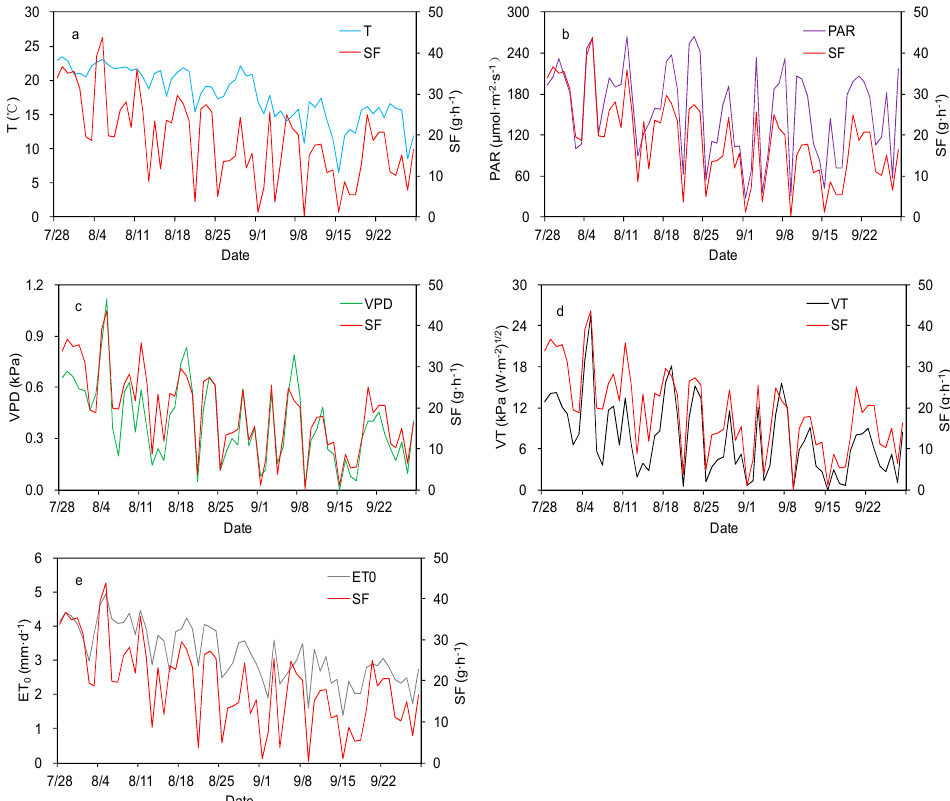
Figure A2. Regression relationships between the daily SF residuals and VPD.